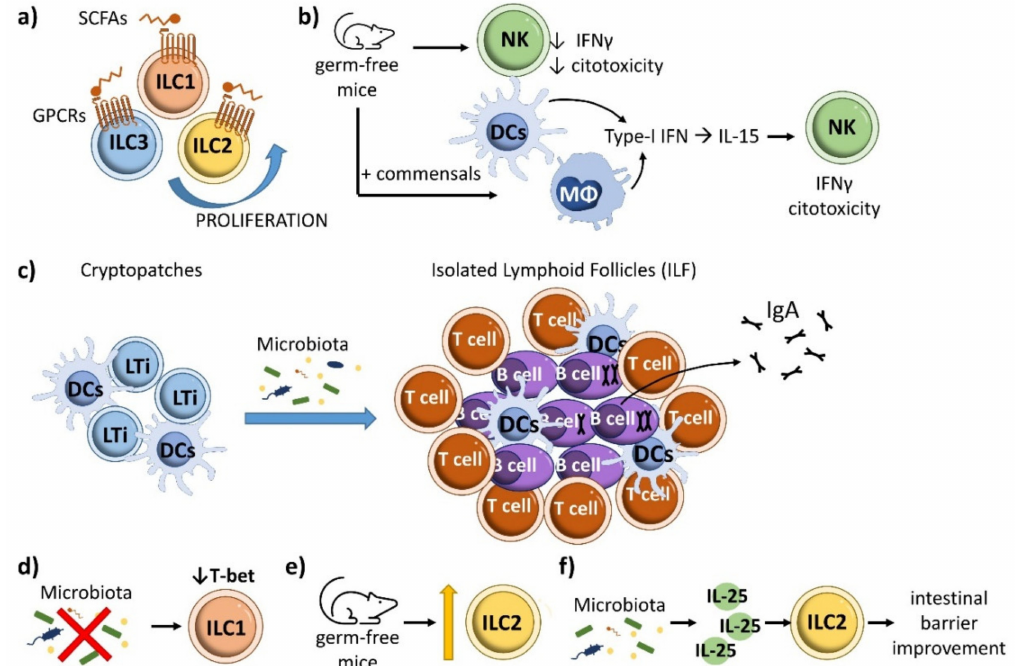
Figure 7. Influence of microbiota in other ILCs in intestinal homeostasis. ( a ) SCFAs produced by the commensal gut microbiota support optimal proliferation of ILC1, ILC2 and ILC3 populations by regulating G protein-coupled receptors (GPCRs). ( b ) In the absence of commensal bacteria, NK cells have reduced cytotoxicity and IFN- γ production. Colonization of germ-free mice with commensals increases NK cytotoxicity through the effect of dendritic cells and macrophage-derived type-I interferons on IL-15, which promotes NK cell terminal maturation. ( c ) LTi cells produce cryptopatches, which are transformed into isolated lymphoid follicles in a microbiota-dependent manner, supporting the production of intestinal IgA. ( d ) The gut microbiota enhances the expression of T-bet in ILCs. ( e ) The proportion of ILC2s in the gut is increased in the absence of commensal microbiota. ( f ) The microbiota regulates ILC2 function in the gut by promoting the release of IL-25, which drives ILC2s to improve intestinal barrier